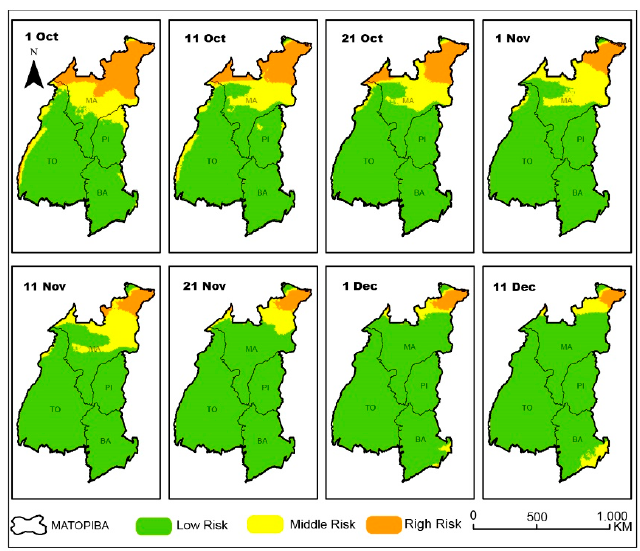
Figure 5. Agroclimatic risk of soybean culture in the MATOPIBA region for the favorable (wet) scenario.